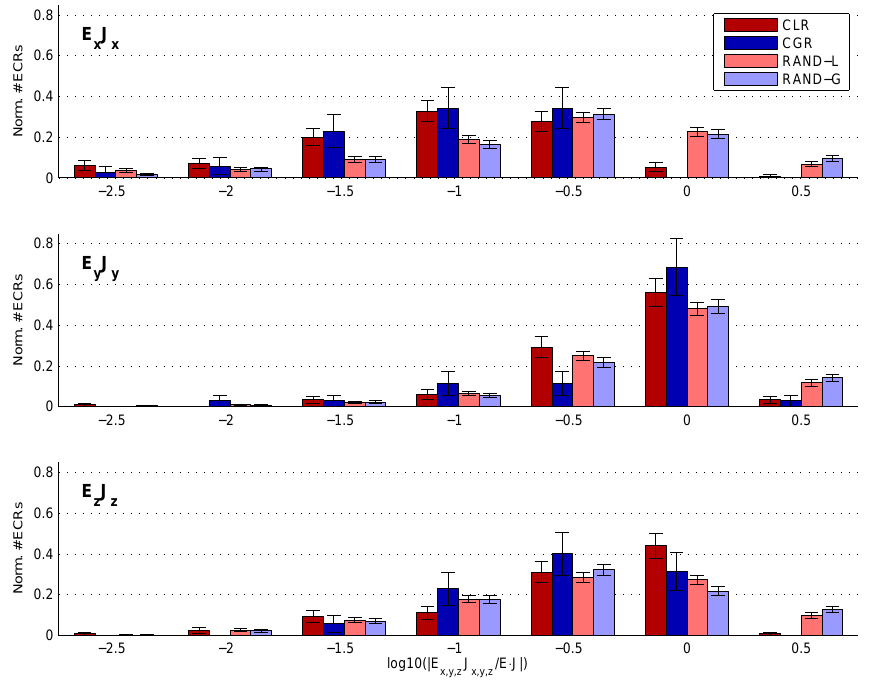
Fig. 8. Histograms of the contribution from various direction to the total power density, | E x J x / E · J | , | E y J y / E · J | , and | E z J z / E · J | , respectively. The DSI coordinate system has been used for the different electric field and current density components. Red and blue correspond to CLRs and CGRs, respectively, while light red and light blue to RAND-Ls and RAND-Gs. We see that most events have | E y J y / E · J |∼ 1, i.e., E y J y dominates the power density both for CLRs and CGRs (and also for the RAND